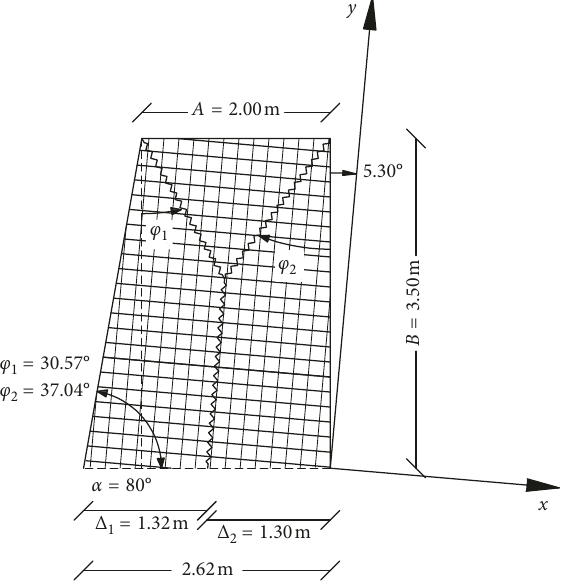
Figure 13: Optimum grid orientation for the slab of Figure